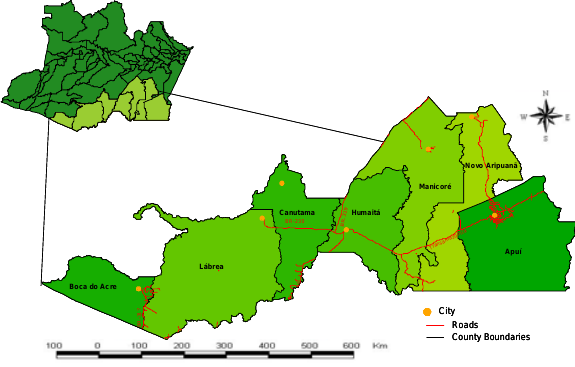
Figure 1. Location of the Amazon State and the cities of: Boca do, Lábrea, Canutama, Humaitá, Manicoré, Novo Aripuanã and Apuí.